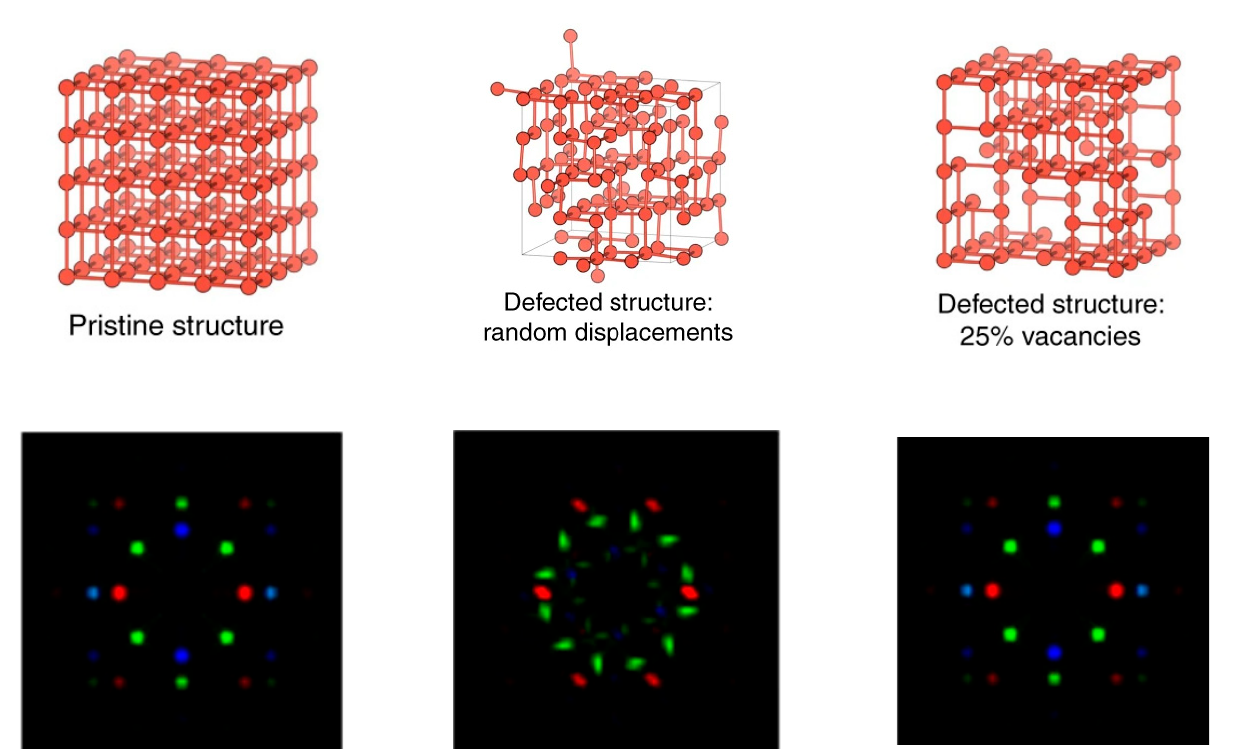
Figure 1. (top) Images of Pristine surface and different severity cases of crystal structures [5] (bottom) Diffraction structure of normal surface and different severity cases of crystal structures.